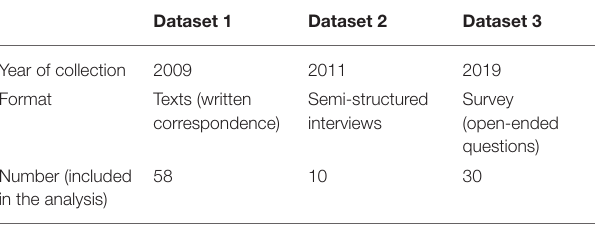
TABLE 1 | Datasets of this